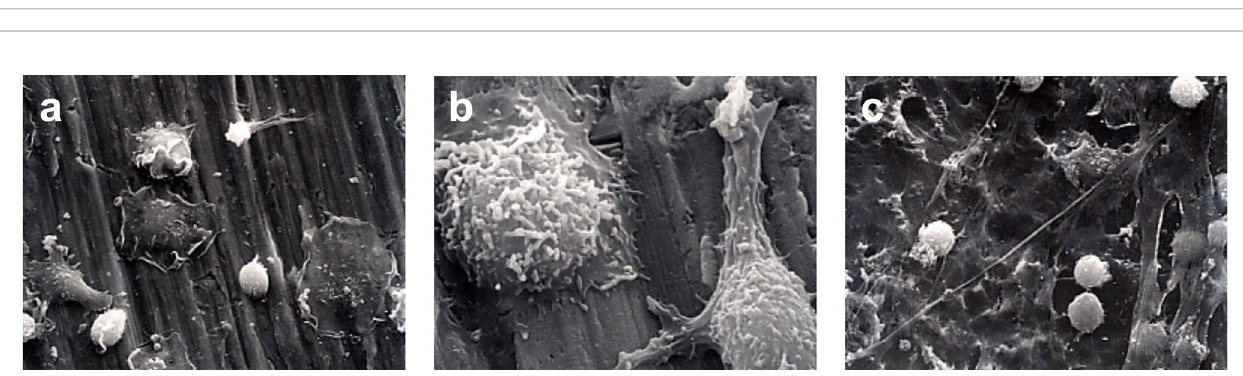
FIGURE 3 | Monocyte priming. SEM photomicrographs of monocytes incubated with surface-modi fi ed titanium prior to secondary stimulation with PMA. (A) 1250x Group 1 30-min incubation. (B) 5000x Group 1 60-min incubation. (C) 1250x Group 2 30-min incubation. (D) 5000x Group 2 60-min incubation. (E) 1250x Group 3 30-min incubation. (F) 5000x Group 3 60-min incubation. (G) 1250x Group 4 30-min incubation. (H) 1250x Group 5 30-min incubation. (I) 5000x Group 5 60-min incubation. (J) 1250x Group 6 30-min incubation. (K) 5000x Group 6 60-min